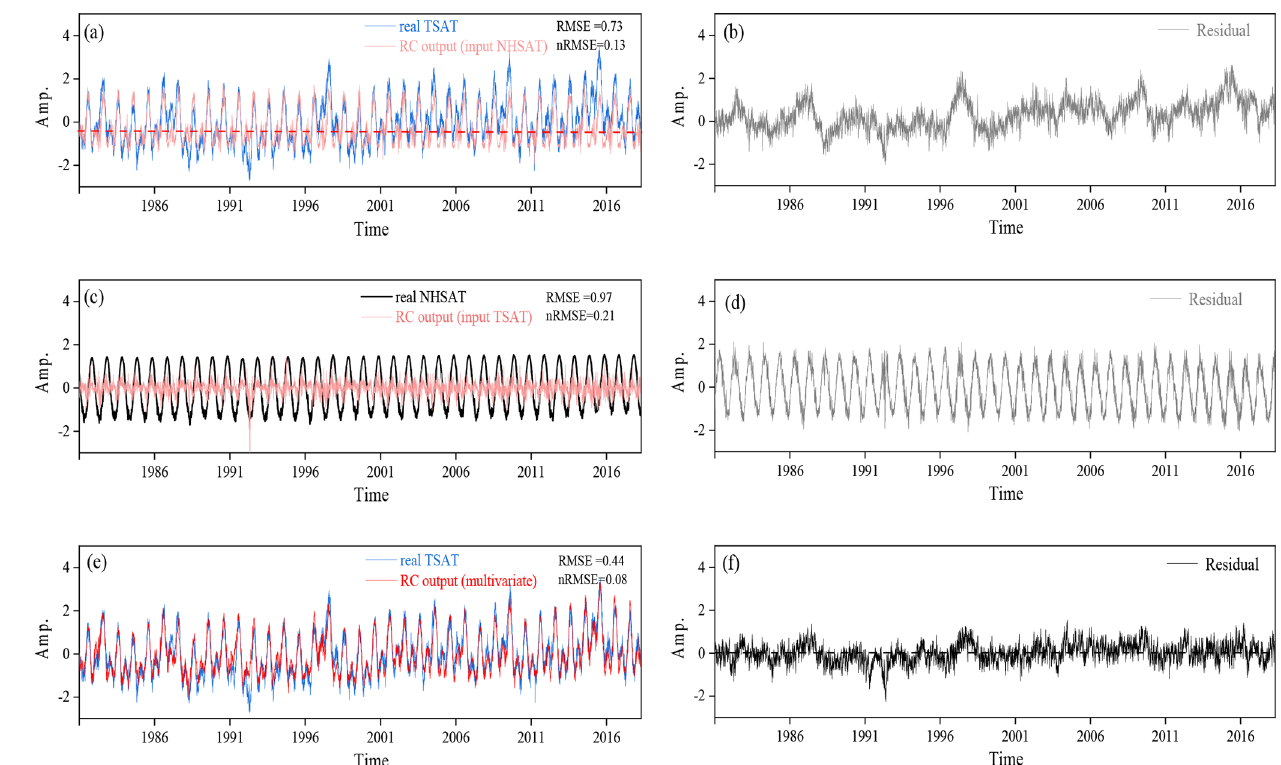
Figure 11. (a) Reconstructed TSAT time series from NHSAT, and its residual series (b) ; (c) reconstructed NHSAT time series from TSAT, and its residual series (d) ; (e) reconstructed TSAT time series from NHSAT and Nino 3.4 index, and its residual series (f) . Table 4. Details of the temperature record reconstruction. Input Output Corr. ρ a → b Data length Neural RMSE nRMSE ( a ) ( b ) (training/testing) network RC 0 .